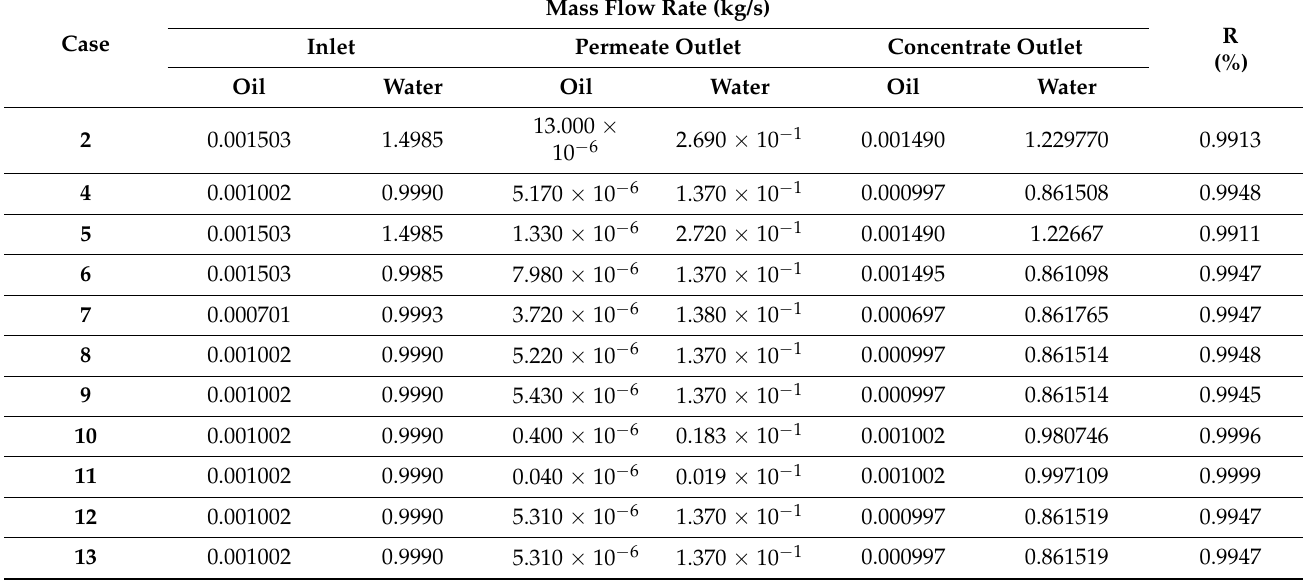
Table 8. Mass flow rate at the inlet and outlet of the module system and rejection coefficient for all simulated cases.